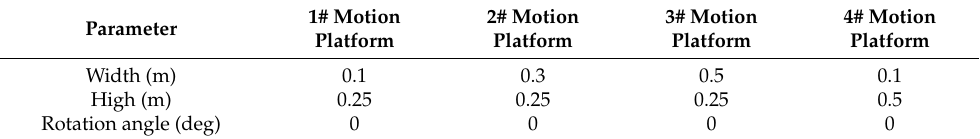
Table 1. The simulation parameters.